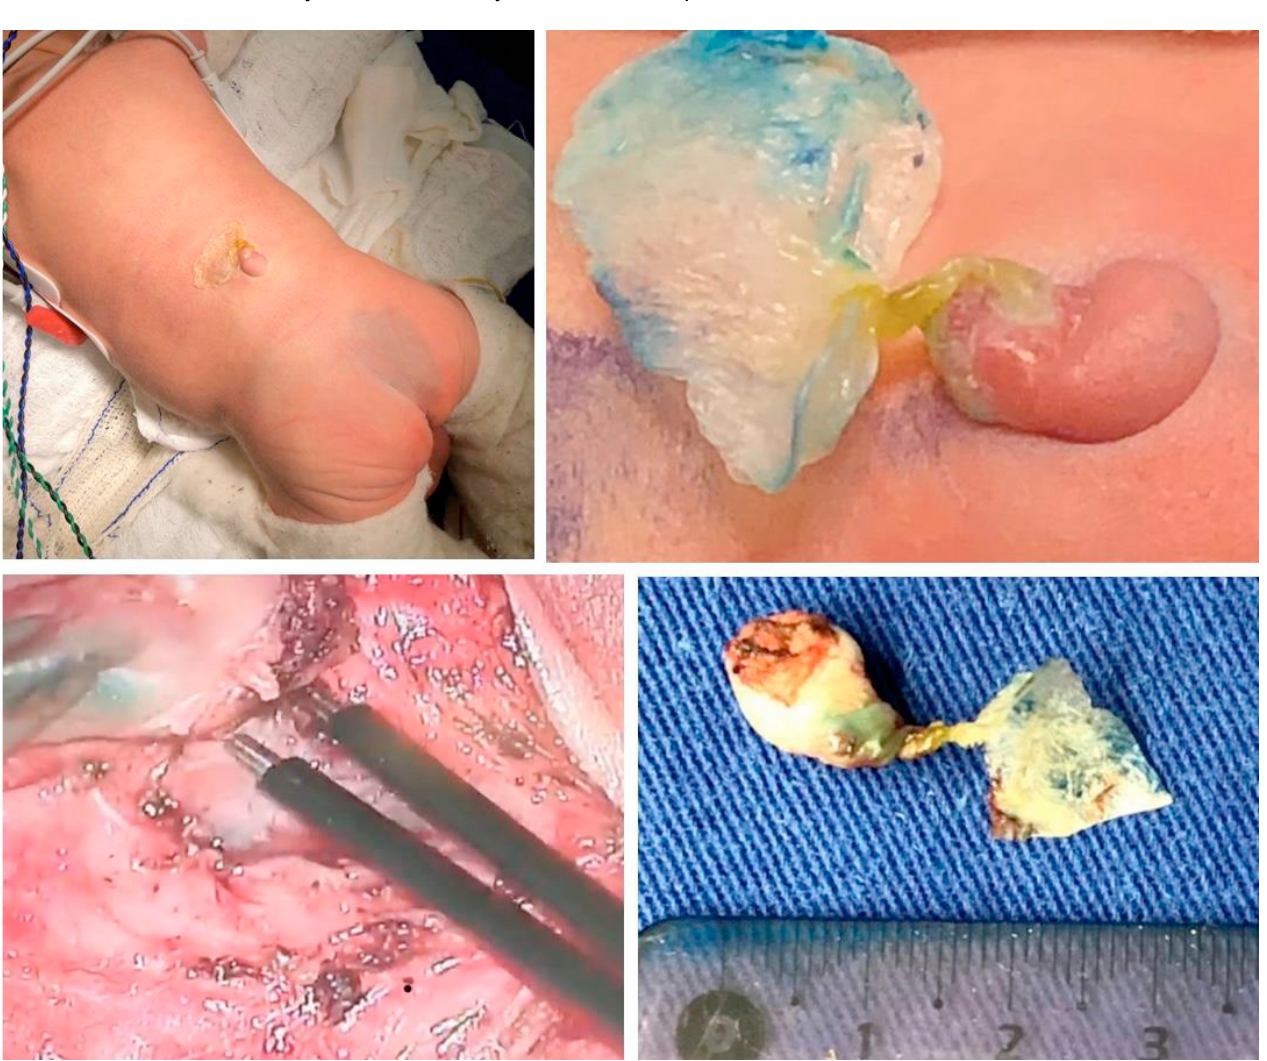
Figure 2 – Images of surgical approach of Amniotic band/Human tail en bloc resection demonstrating a position of appendage, electrode of neurophysiologic monitorization and after resection positivation after seven day of hospital